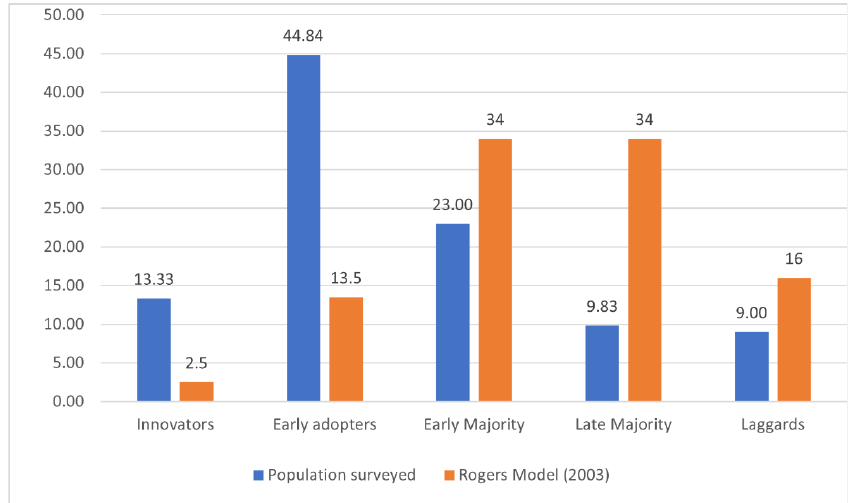
Figure 1. Comparison of the studied population’s distribution with Rogers’ model, accounting for innovation level (%).